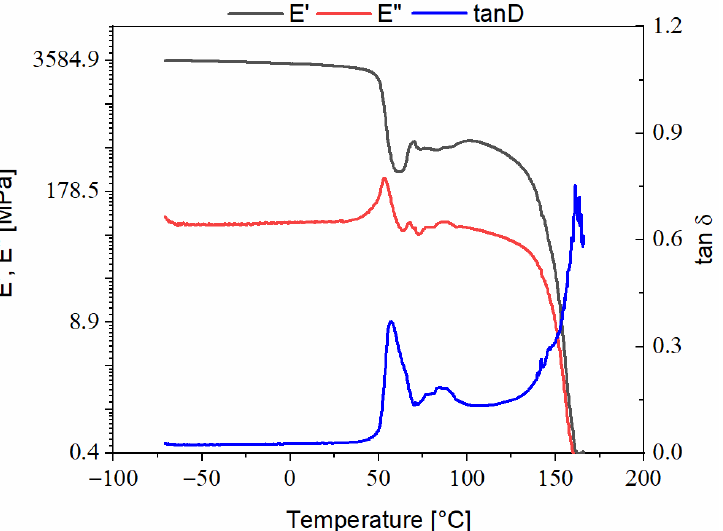
Figure 4. DMA thermogram recorded during heating of Arboform ® LV3 Nature reinforced with aramid fibers.